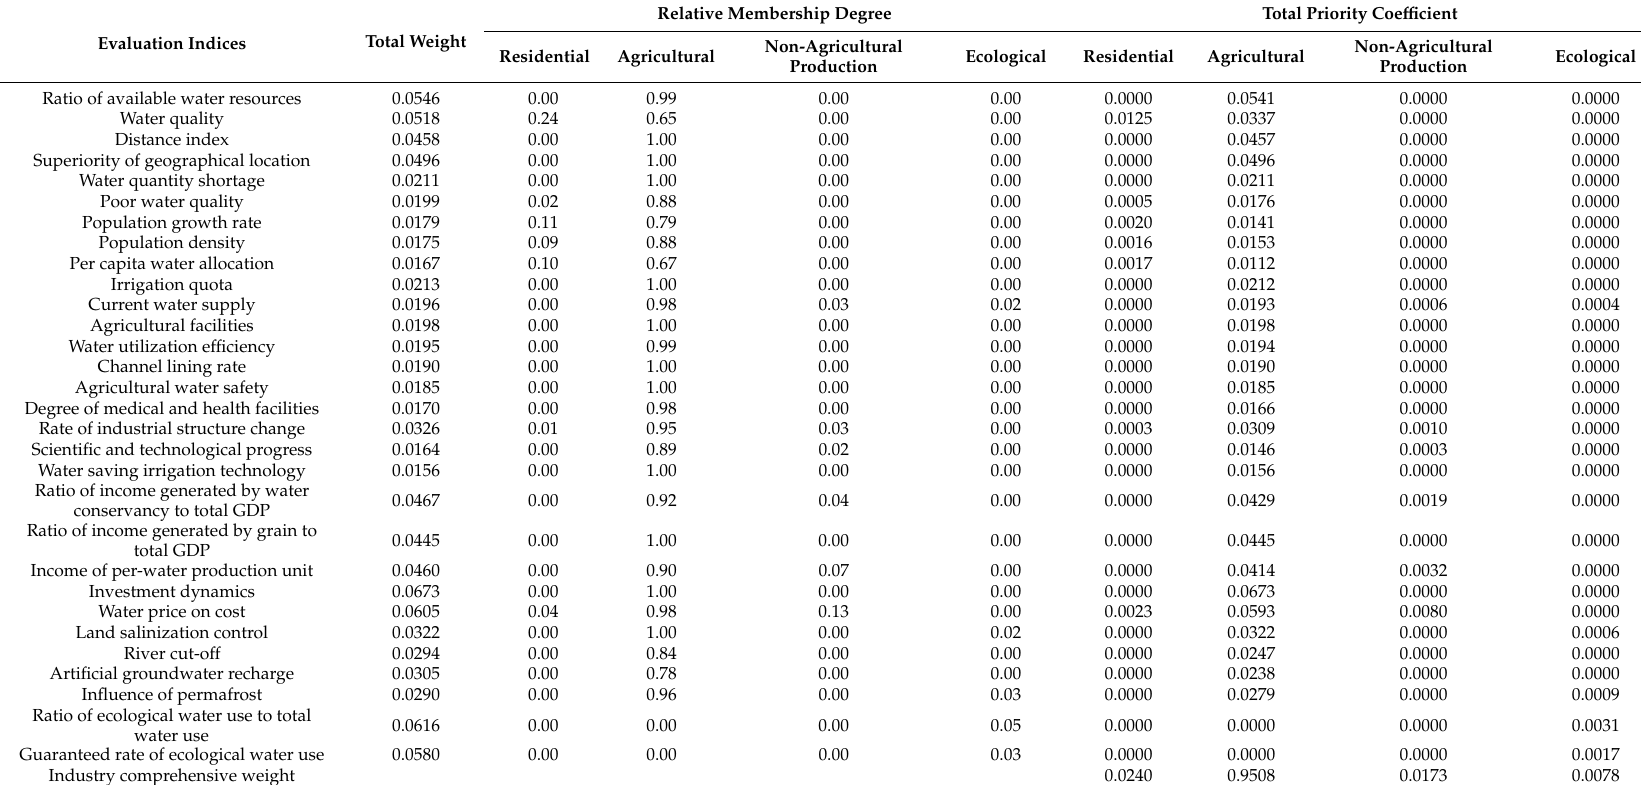
Table 4. The total priority coe ffi cient of water use in di ff erent